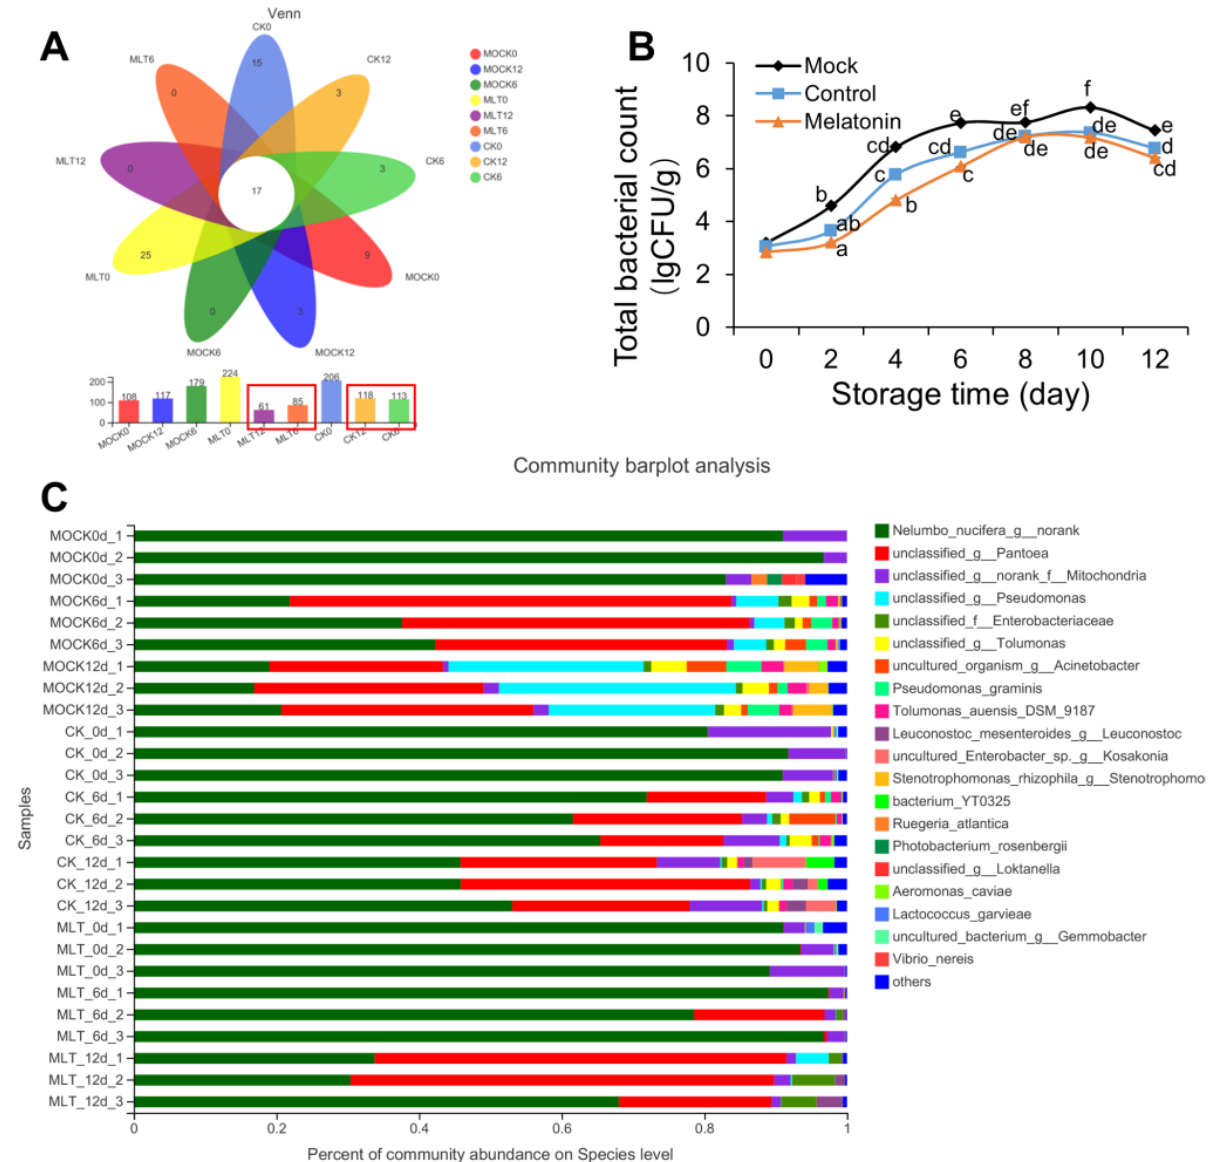
Figure 4. Effect of melatonin on common and unique species. ( A ) Venn analysis of the number of common and unique species in different samples. ( B ) Total bacterial count of samples after treat- ment. ( C ) Microbial community composition of fresh-cut lotus roots. Error bars represent SEs from three biological replicates. Different letters represent significant differences at p < 0.05 level.